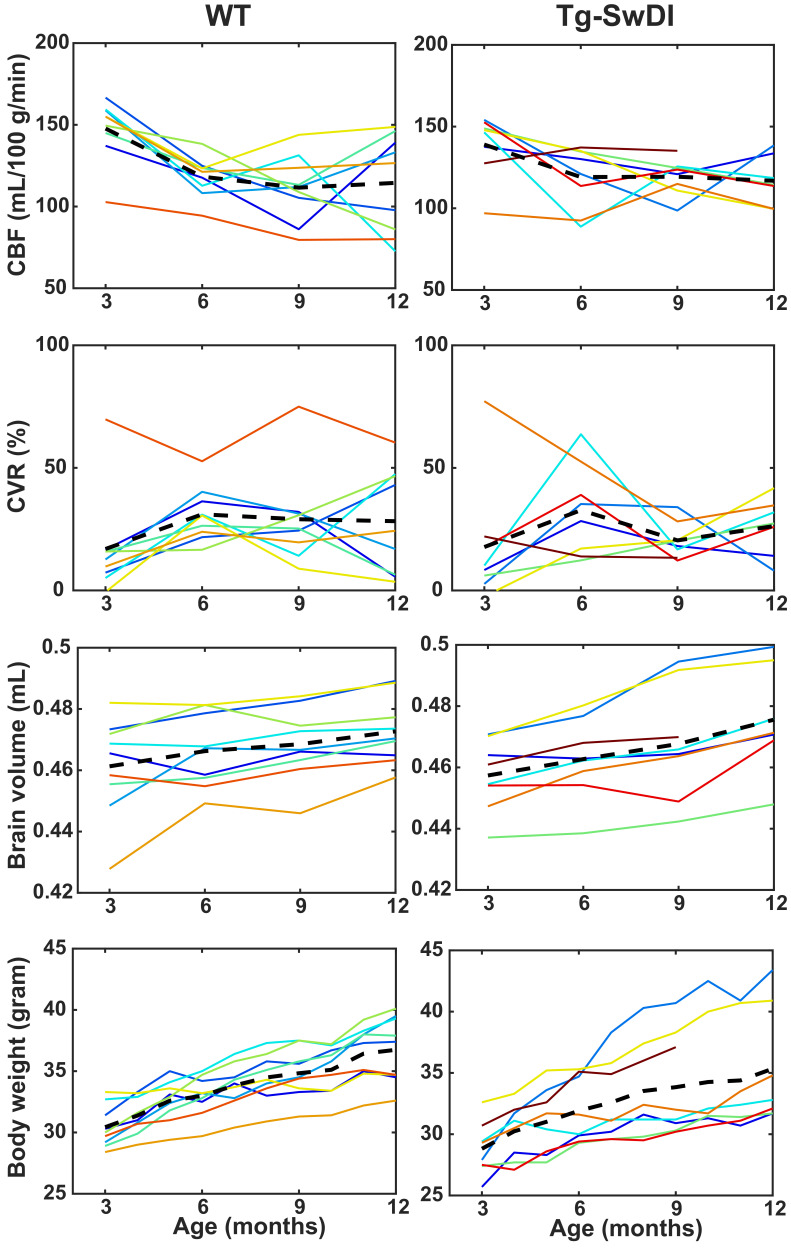
Animal-by-animal cerebral blood flow (CBF), cerebrovascular reactivity (CVR), brain volume, and body weight progression with increasing age.On the top row, CBF trends are displayed, on the second row CVR trends, on the third row brain volume, and on the last row body weight. The left column shows wild-type (WT) mice, and the right column transgenic Swedish Dutch Iowa (Tg-SwDI) mice. Every animal is represented with the same line color in the four graphs. The black dashed line represents the group mean.